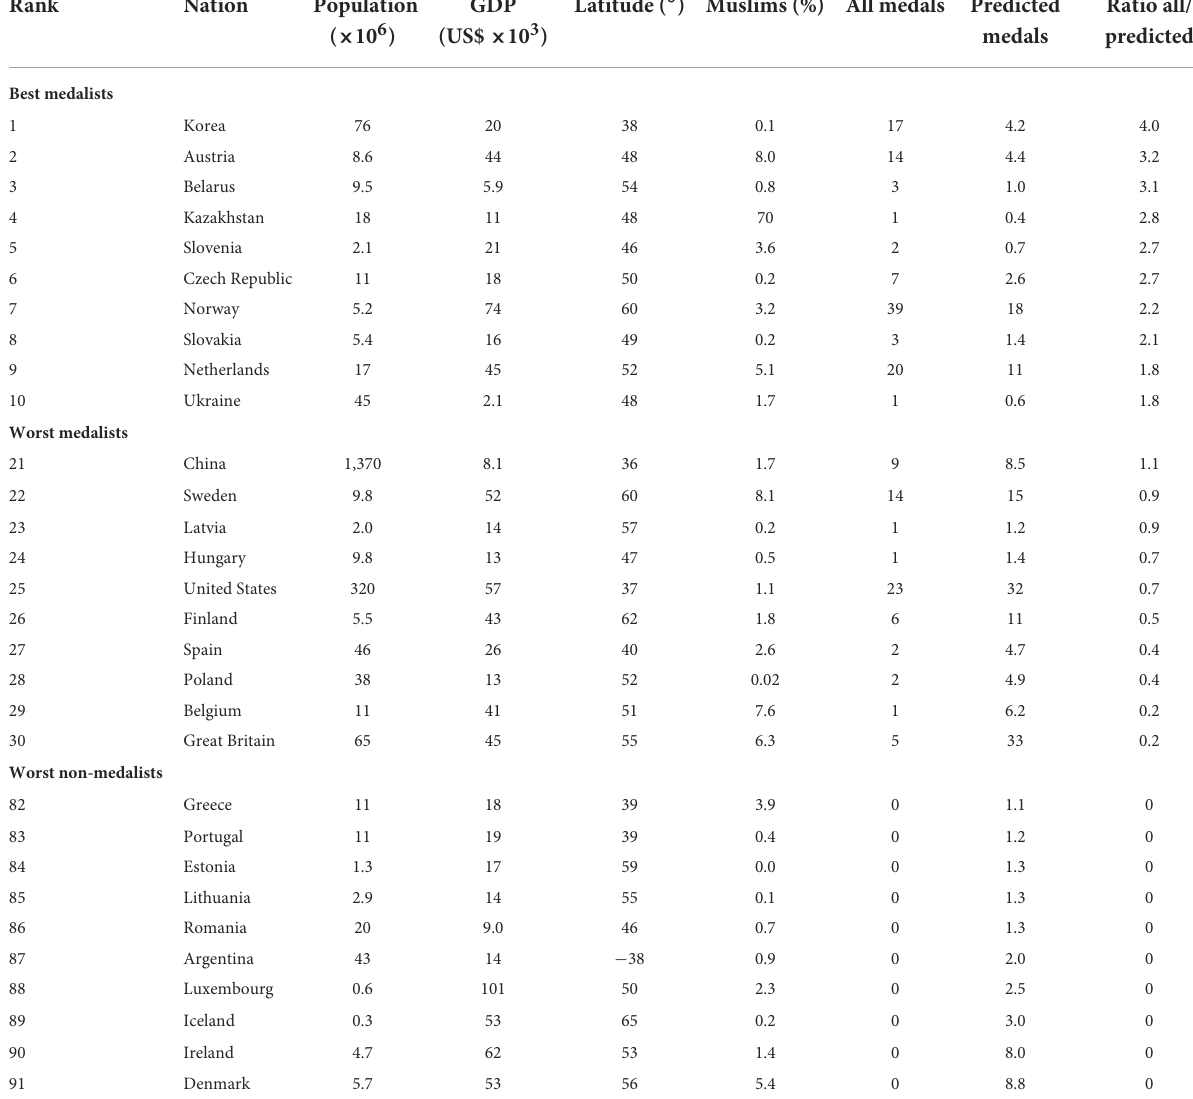
TABLE 4 Ranking of the best medalists, worst medalists and worst non-medalists at the Pyeongchang winter Olympics. Rank Nation Population